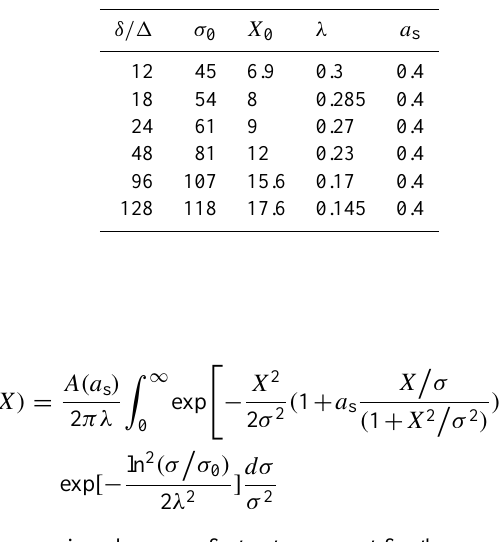
Table 1. Values of four parameters in the modified Castaing model, Eq. (2), used in the fit of P(δv || ,δ) based on the JHU turbulence data for the scale δ between 12 1 and 128 1 .